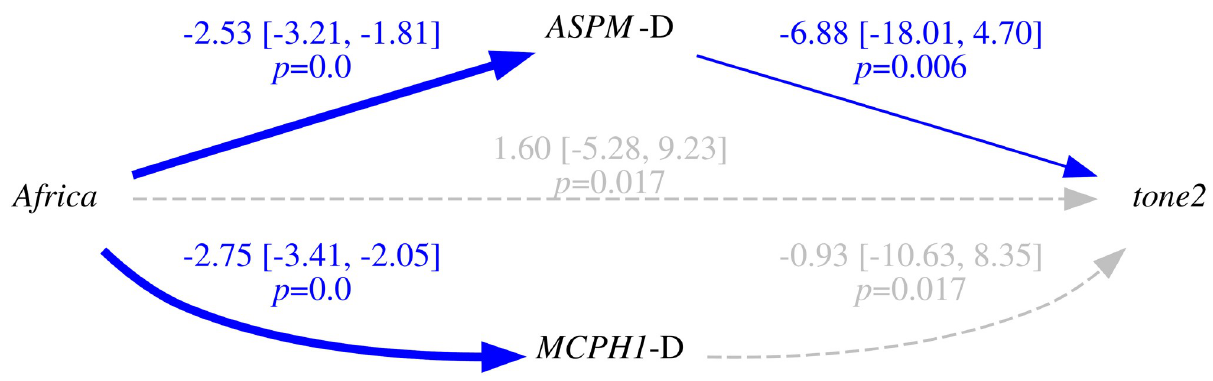
Fig 21. The simultaneous mediation model for tone2 through both “derived” alleles. Same conventions as in Fig 12.